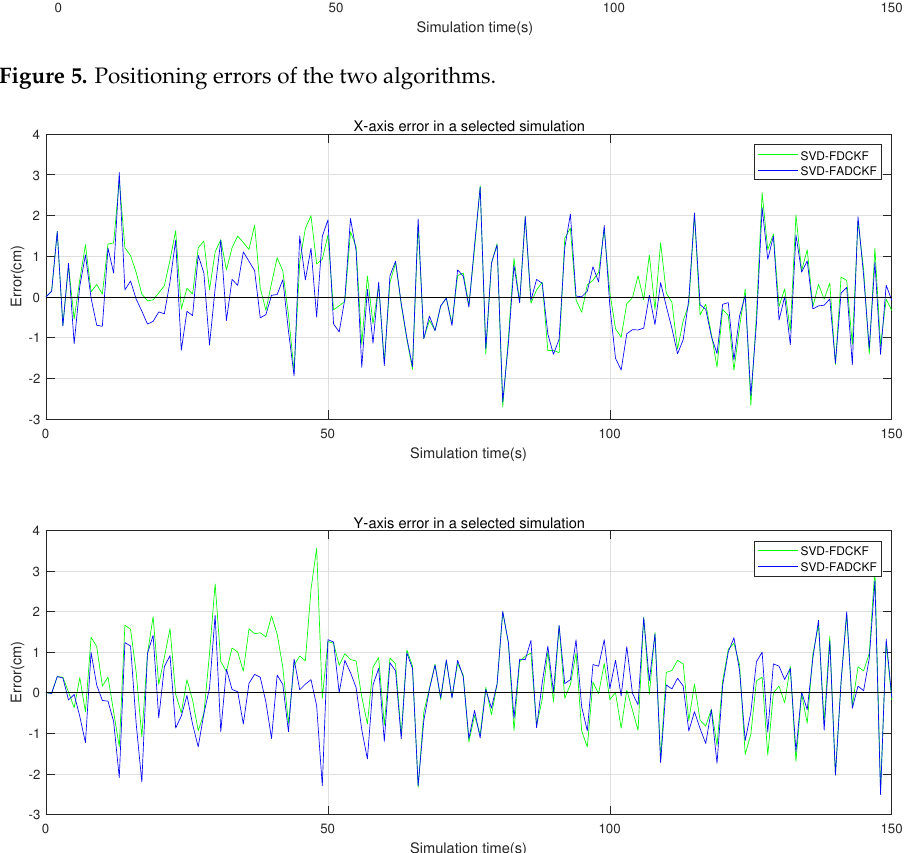
Figure 6. X -axis and Y -axis errors of the two algorithms in selected